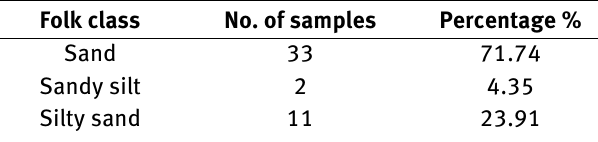
Table 2: Folk soil classification for Tigris River bed samples [25].